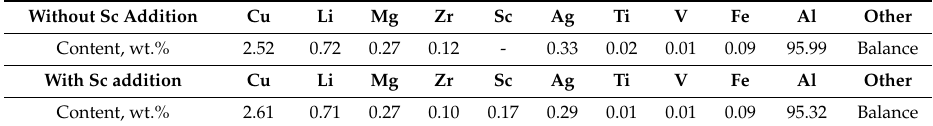
Table 2. Chemical compositions of twin-roll cast